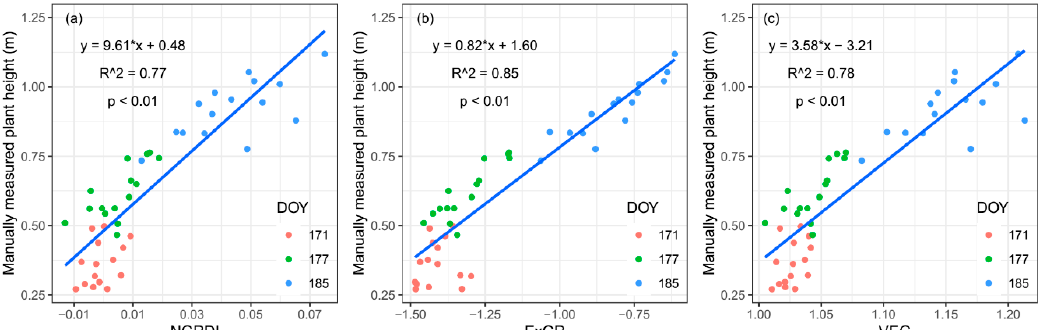
Figure 12. Correlations between three vegetation indices derived from UAV RGB imagery and maize manually measured plant height, respectively. ( a ) Normalized green-red difference index (NGRDI); ( b ) excess green minus excess red (ExGR); ( c ) vegetation index (VEG). p < 0.01 represents the significance level.